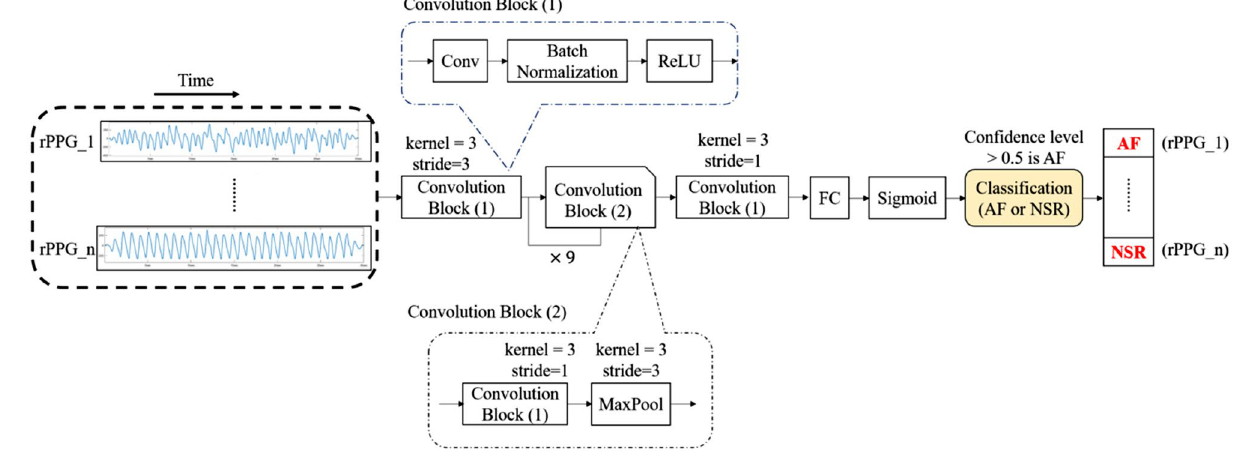
Figure 2. The overall DCNN model